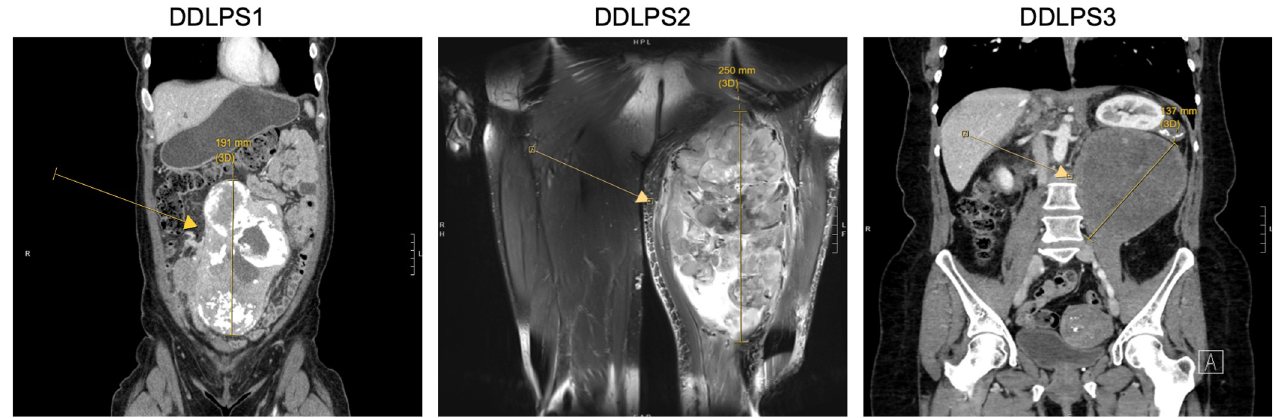
Fig 2. Computed tomography scans (DDLPS1 and DDLPS3) and a T2 fat-suppressed magnetic resonance image (DDLPS2) of patients with DDLPS. The tumor of patient DDLPS3 was mostly well differentiated liposarcoma, which is reflected on imaging by the low density, homogenous appearance.